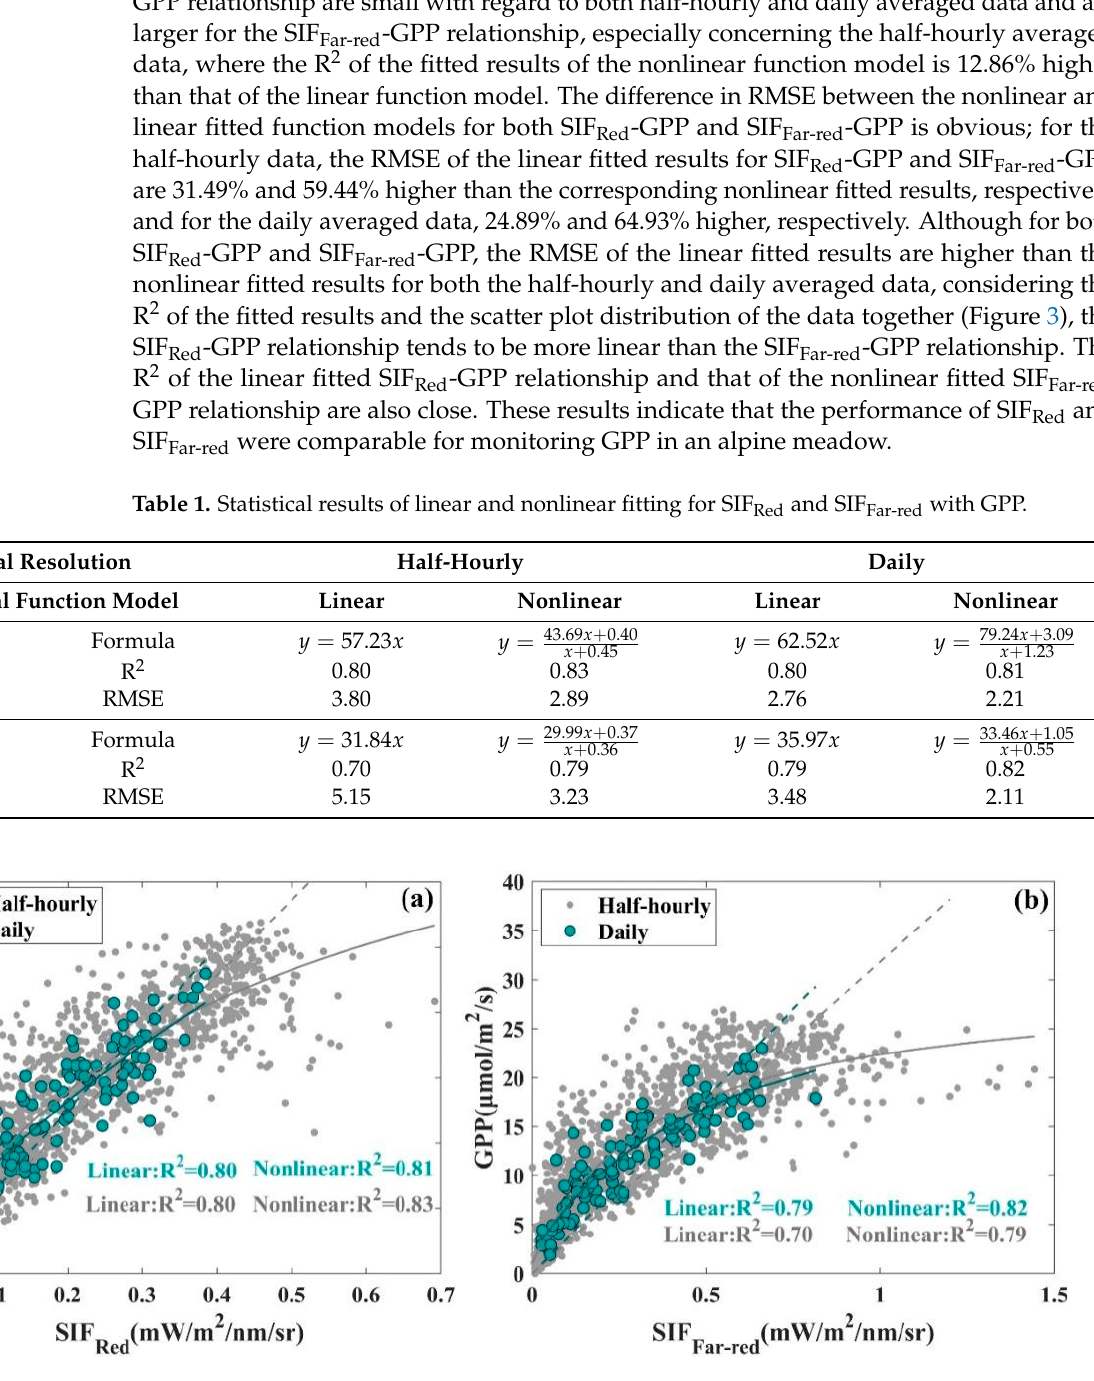
Figure 3. The relationship between SIF Red ( a ), SIF Far-red ( b ), and GPP at the seasonal scale at the AR site, large green dots represent daily averaged data, small gray dots represent half-hourly averaged data, the dashed lines represent linear fit lines, the solid lines represent non-linear fit lines, and the green and gray lines represent the daily averaged data fit lines and the half-hourly averaged data fit lines of SIF and GPP, respectively. Table 1. Statistical results of linear and nonlinear fitting for SIF (cid:2902)(cid:2915)(cid:2914) and SIF (cid:2890)(cid:2911)(cid:2928)(cid:2879)(cid:2928)(cid:2915)(cid:2914) with GPP. Temporal Resolution Half-Hourly Daily Mathematical Function Model Linear Nonlinear Linear Nonlinear Formula